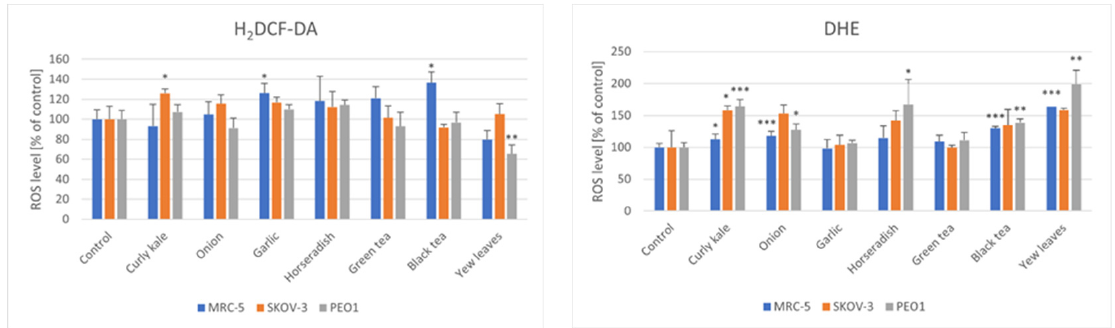
Figure 5. Effect of vegetable extracts and infusions on the level of reactive oxygen species in PEO1, SKOV-3 and MRC-5 cells, estimated with 2 ′ ,7 ′ -dichlorodihydrofluorescein diacetate (H 2 DCF-DA) and dihydroethidium (DHE); * p < 0.05, ** p < 0.001, *** p < 0.001 (with respect to Control).